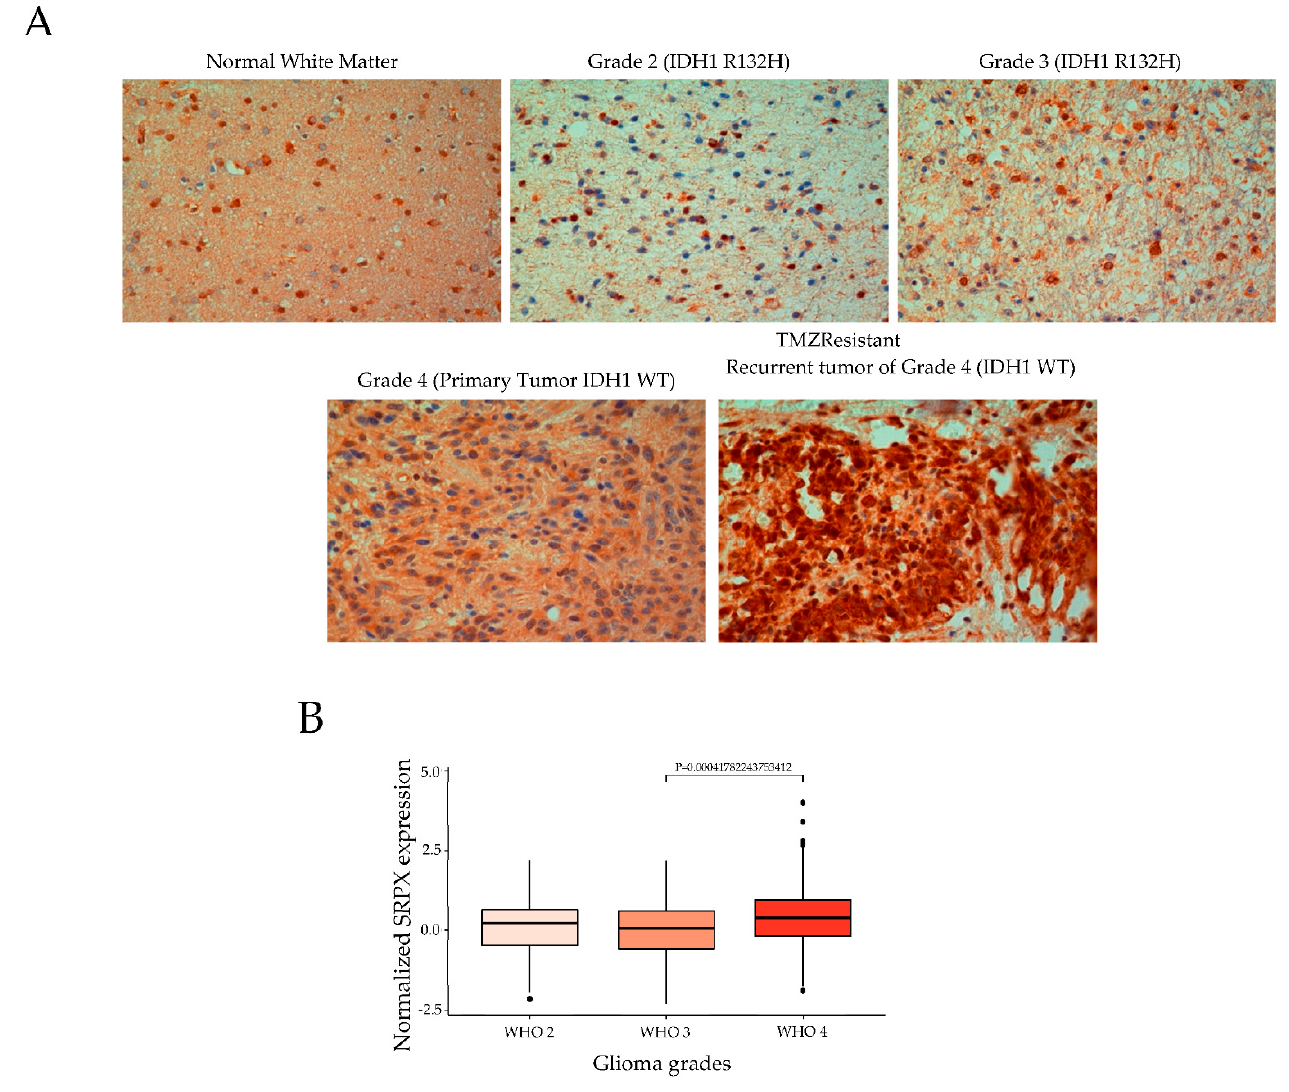
Figure 2. SRPX is a marker for glioblastomas. ( A ) Immunohistochemistry (IHC) of SRPX on FFPE tissue sections from grade 2 ( n = 3), grade 3 ( n = 3), grade 4 ( n = 3) and recurrent tumors of grade 4 ( n = 3) (lower panels show primary and recurrent tumor from the same grade patient). White matter biopsies were used as a negative control. Representative images from each grade are shown.